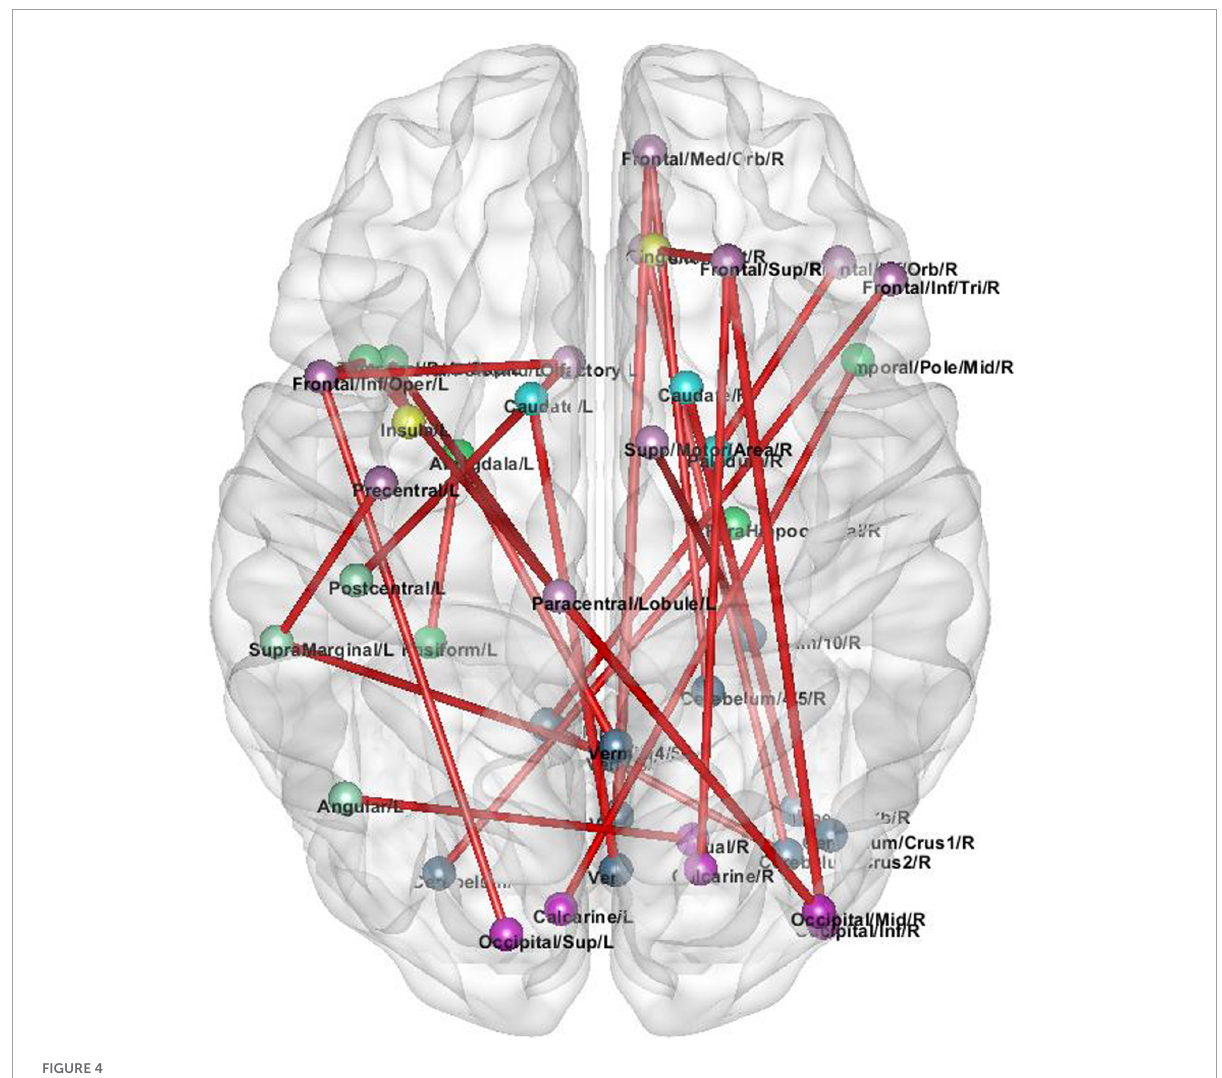
FIGURE4 The selected high-order brain functional connections.